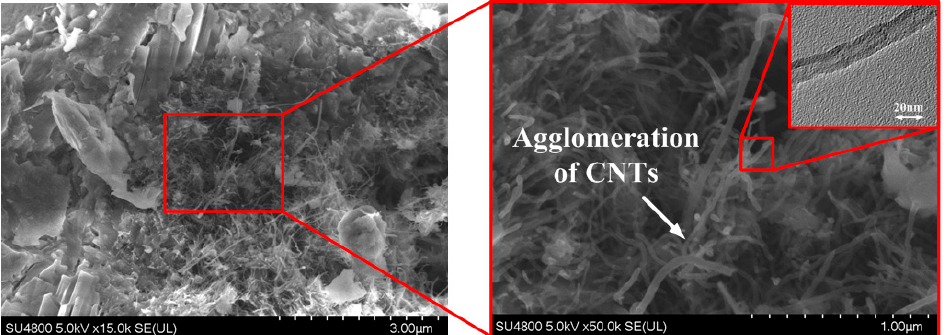
Figure 10. SEM images taken from the 28 day HPC hardened paste samples.